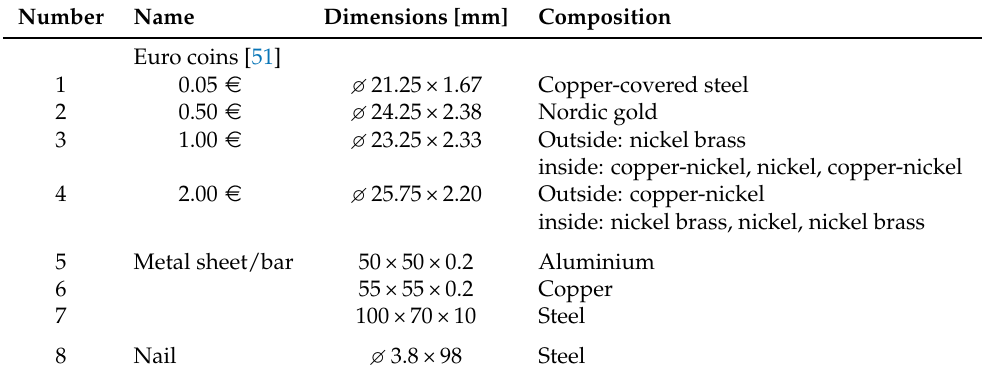
Table 3. Test objects used as metallic foreign